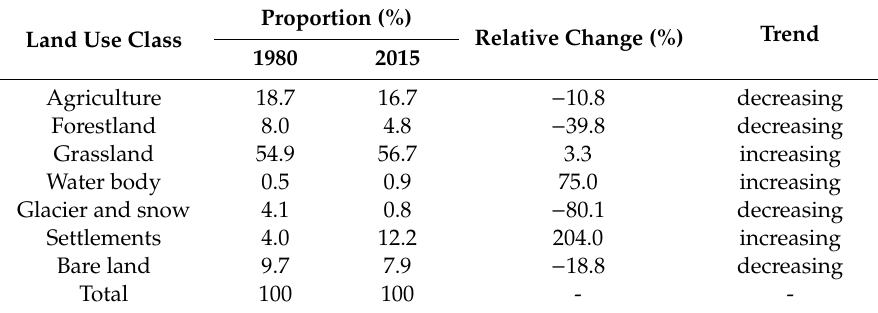
Table 4. Changes in land use / land cover during 1980 and